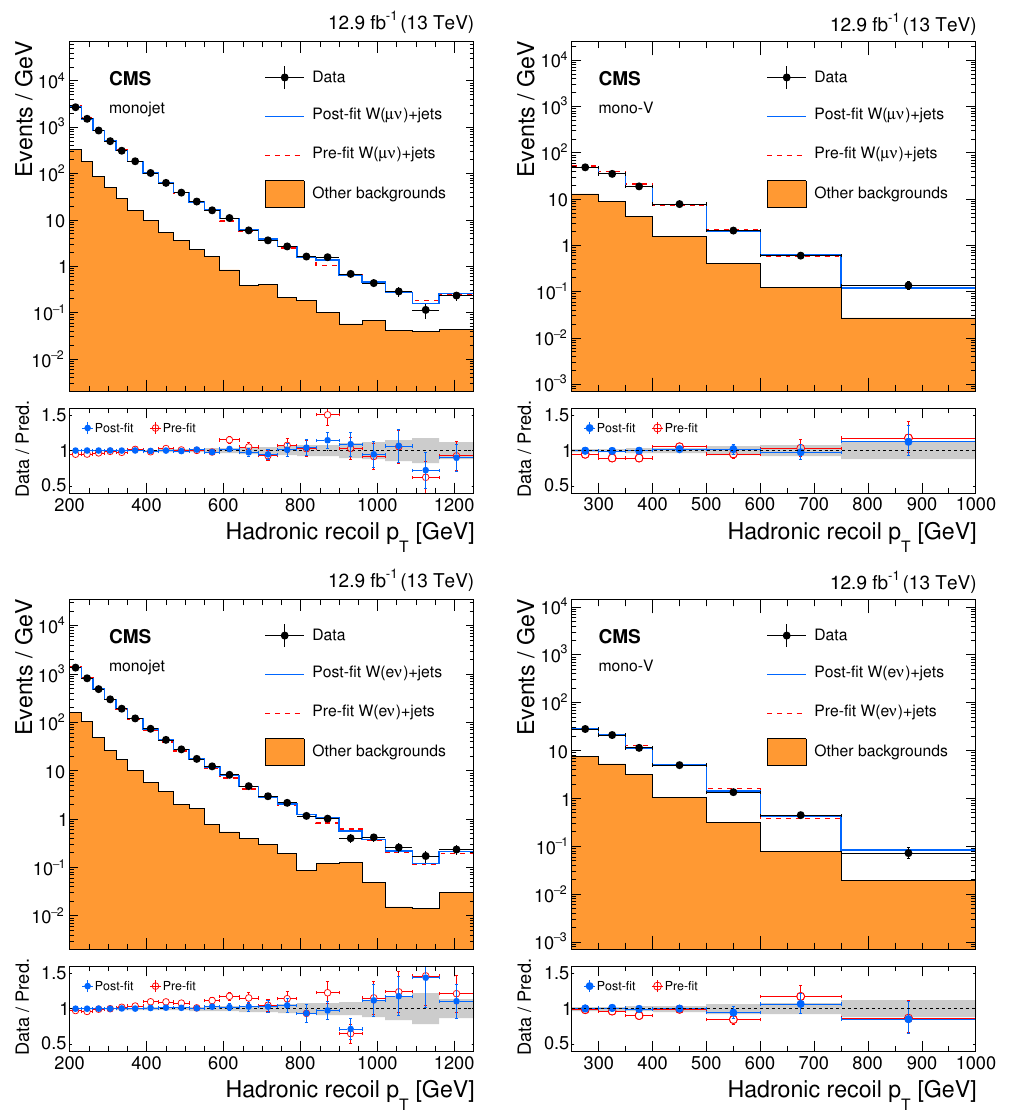
Figure 5 . Comparison between data and Monte Carlo simulation in the single-lepton control samples before and after performing the simultaneous (cid:12)t across all the control samples and the signal region, assuming the absence of any signal. Plots on the upper left and right correspond to the monojet and mono-V categories, respectively, in the single-muon control sample. Plots on the bottom left and right correspond to the monojet and mono-V categories, respectively, in the single- electron control sample. The hadronic recoil p T in single-lepton events is used as a proxy for E miss in the signal region. The (cid:12)lled histogram indicates all processes other than W( ‘(cid:23) )+jets. Ratios of data and the pre-(cid:12)t background prediction (red points) and post-(cid:12)t background prediction (blue points) are shown for both the monojet and mono-V signal categories. The gray band indicates the overall post-(cid:12)t uncertainty. The last bin includes all events with hadronic recoil p T larger than 1160 (750) GeV in the monojet (mono-V)